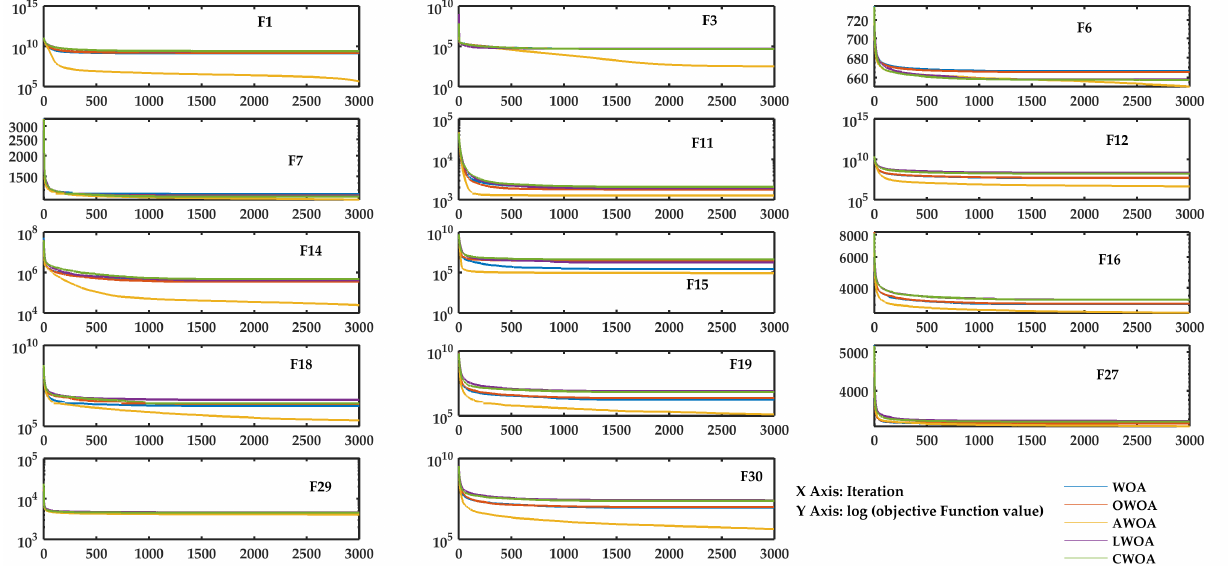
Figure 12. Boxplot analysis of the remaining 30D functions of Benchmark Suite 2.